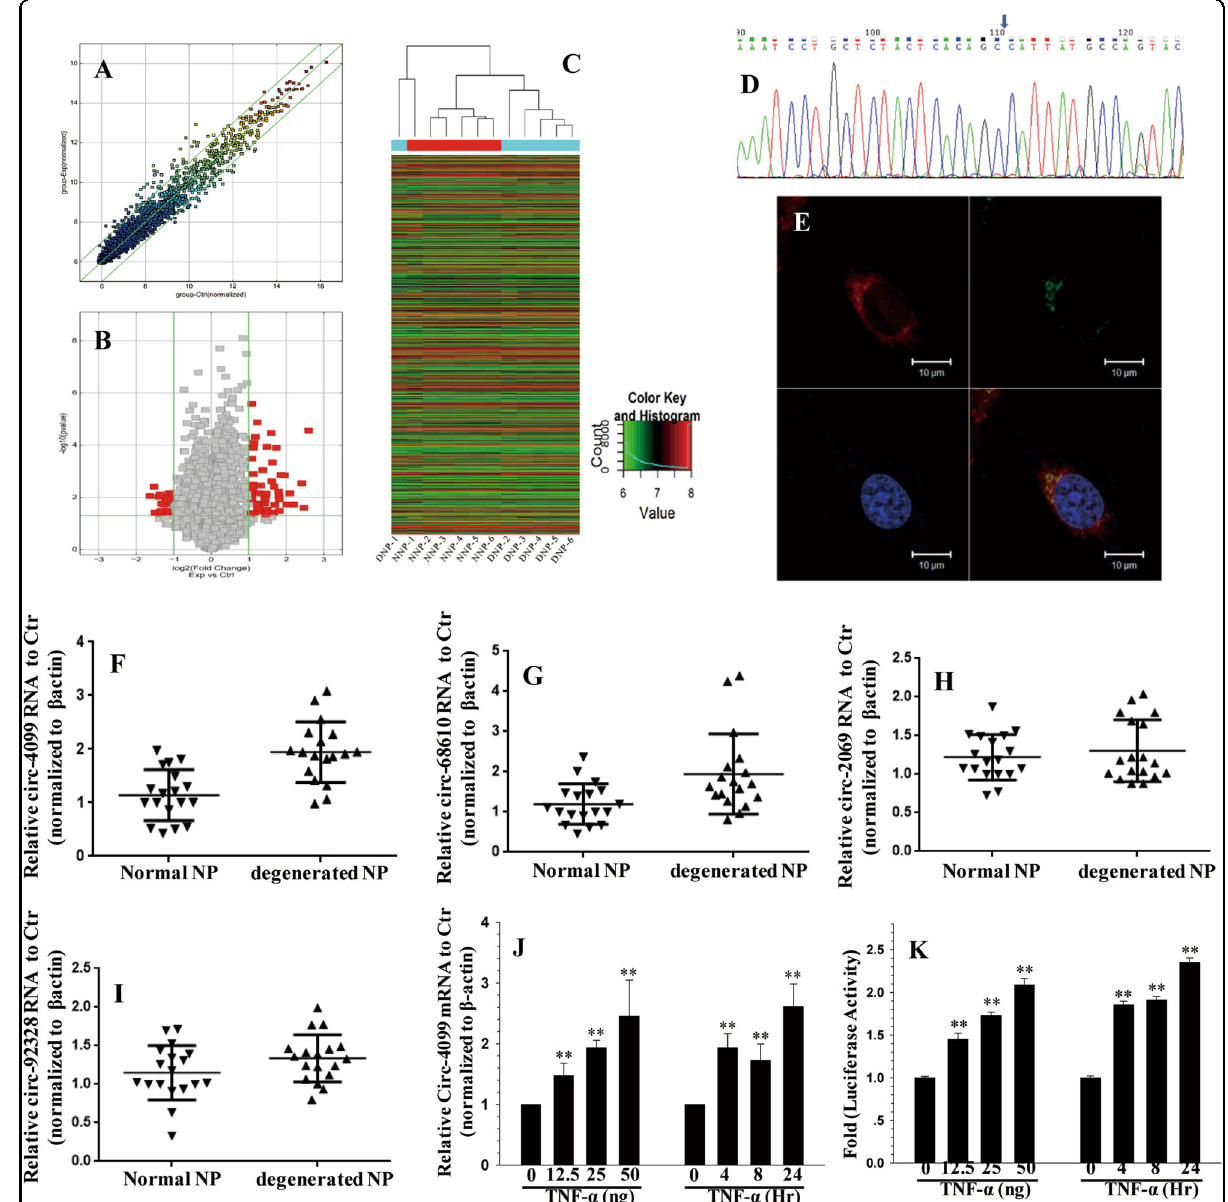
Fig. 1 circRNA pro fi le in IVDD. a Scatter plot of circRNA expression. The circRNAs above the top green line and below the bottom green line indicated more than a twofold change between the degenerated and normal IVD NP tissues. b Volcano Plot of the differentially expressed circRNAs. The red points in the plot represent differentially expressed circRNAs with statistical signi fi cance. c Hierarchical clustering shows the distinguishable circRNA expression pro fi le between the two groups and homogeneity within the groups. d The sequence of the ampli fi ed Circ-4099 product was completely consistent with CircBase. e Co-localization between circ-4099 (red) and miR-616-5p (green) was observed by RNA in situ hybridization in hNP cells after co-transfection with circ-4099-expressing and miR-616-5p-expressing vectors. The nuclei were stained with DAPI (blue). Scale bar = 10 µm. f The expression levels of circ-4099 are signi fi cantly higher in degenerated NP tissues than in non-degenerated NP tissues. g – i The expression levels of circ-68610/2069/92328 are higher in degenerated NP tissues than in non-degenerated NP tissues. j qRT-PCR analysis shows that TNF- α upregulates the expression of circ-4099 in a dose-dependent and time-dependent manner. For time-dependent studies, 50 ng/ml TNF- α was used. k hNP cells were transfected with the circ-4099-Luc promoter and the induction in luciferase activity was measured following TNF- α treatment ( P <